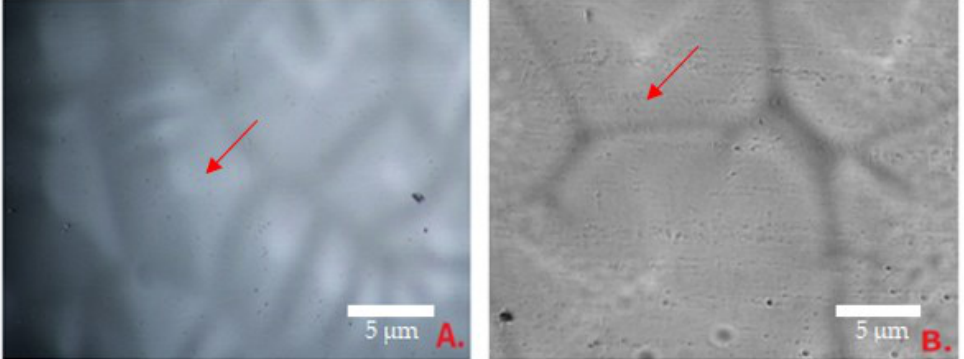
Figure 4. The surface of the film 40 × magnification: ( A ) film No. 6; ( B ) film No. 6K (control compositions); arrows show the dimples of the film surface.